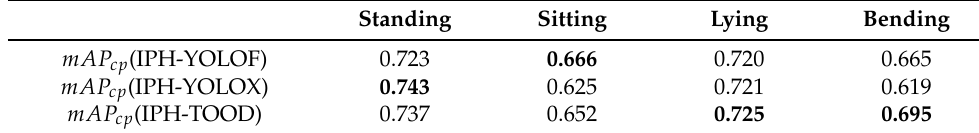
Table 4. Illustration of the mAP cp difference between the three baseline detectors we